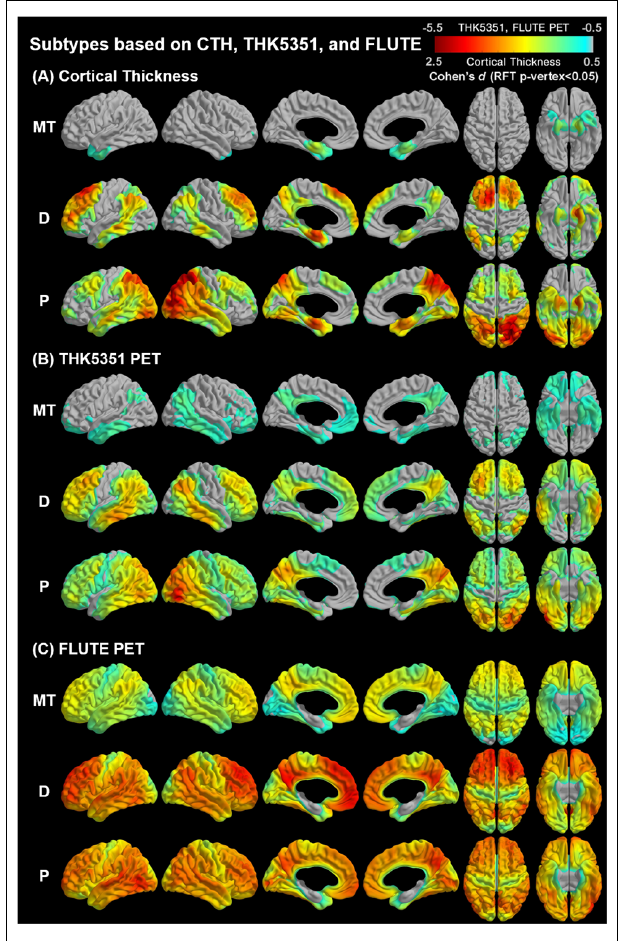
FIGURE 2 | Topographical maps of imaging biomarkers according to AD subtypes. AD, Alzheimer’s disease; MT, Medial temporal-dominant; P, parietal-dominant; D, diffuse atrophy. Comparison of regional (A) cortical thickness, (B) tau retention, and (C) amyloid uptake between identified subtypes and the control group. The color scale indicates the effect size (Cohen’s). Significance was determined based on general linear models controlling for age, sex, and years of education. Intracranial volume was added as a covariate to the cortical thickness analyses. The statistical maps were thresholded using a random field theory ( p -vertex <